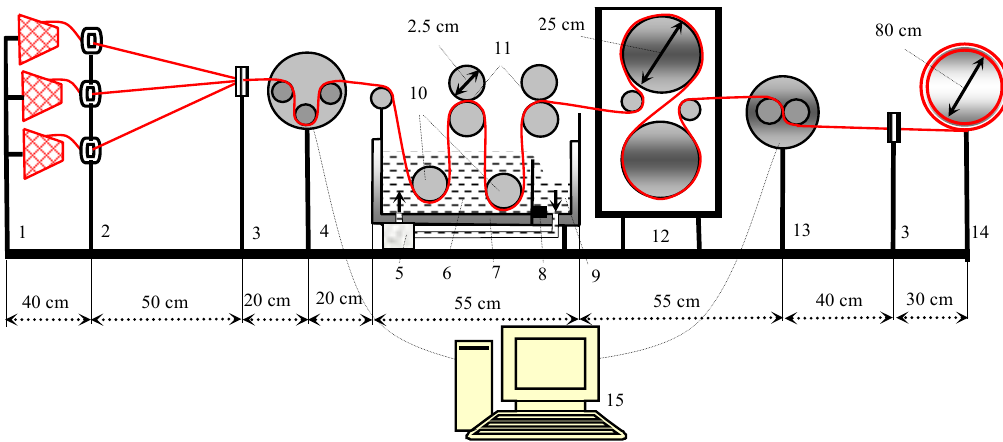
Figure 2. Laboratory sizing machine; 1—creel for cross wound bobbins, 2—thread tensioners, 3—comb, 4—tensiometer, 5—pump, 6—size box, 7—double wall of the size box, 8—thermostat, 9—prewetting size box, 10—immersion rollers, 11—size squeezing rollers, 12—contact dryer, 13—moisture measurement unit, 14—yarn winder, 15—computer with A/D converter for data storage. During the sizing process percentages of the copolymer solution in the water (concentration) for the single yarn were: 5%, 10% and 15%, and for the ply yarn: 1%, 3% and 5%, adapted to industrial